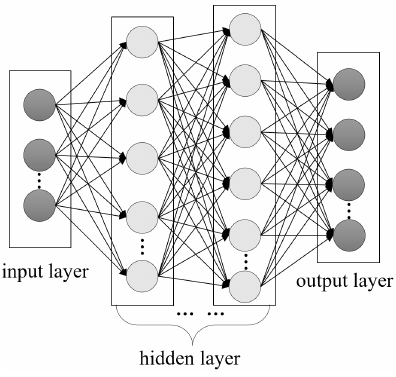
Figure 9. Multi-layer perception (MLP)